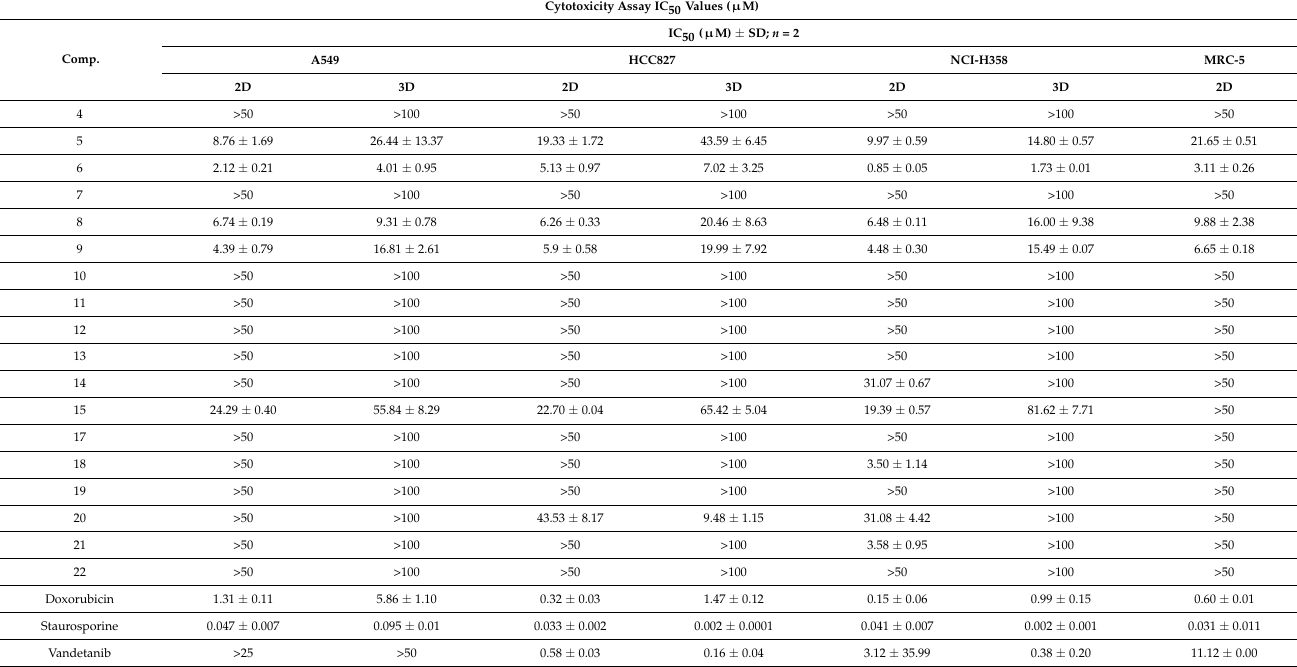
Table 1. Cytotoxicity assays on tested compounds in 2D and 3D assays format. CytotoxicityAssayIC50 Values( µ